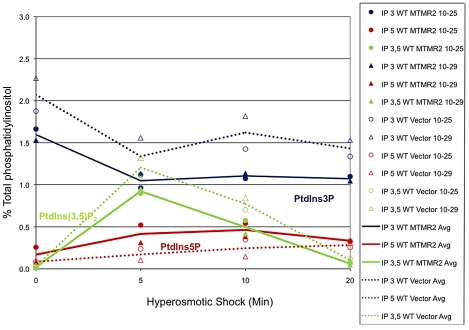
MTMR2 3-phosphatase activity in yeast.Mouse MTMR2 has 3- phosphatase activity in vivo and converts PtdIns(3,5)P
2 and PtdIns3P to PtdIns5P and phosphatidylinositol, respectively. Expression of MTMR2 in yeast causes a decrease in PtdIns3P and PtdIns(3,5)P
2 as well as an increase in PtdIns5P. Mouse MTMR2 cDNA was subcloned into a yeast expression vector, pVT102U (vector) to express MTMR2 from the ADH promoter, pVT102U-MTMR2. Yeast expressing MTMR2 or with vector alone were labeled with 3H-inositol for 18 h. Cells were exposed to 0.9 M NaCl for the times indicated, Lipids were extracted, deacylated, and the corresponding glycerol-inositol phosphates were quantitated by high-pressure liquid chromatography, reported as the percent of total [3H]phosphatidylinositol extracted. Two independent experiments are shown.